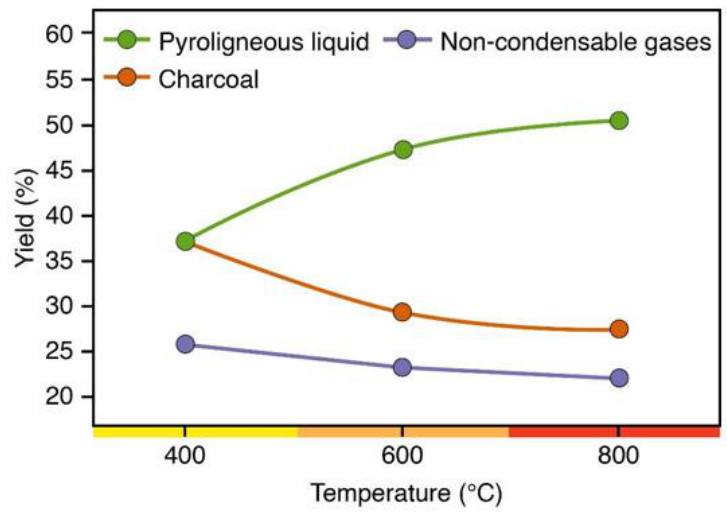
Figure A2. ( a ) Flexural strength test ( b ) and tensile strength test of biocomposites.